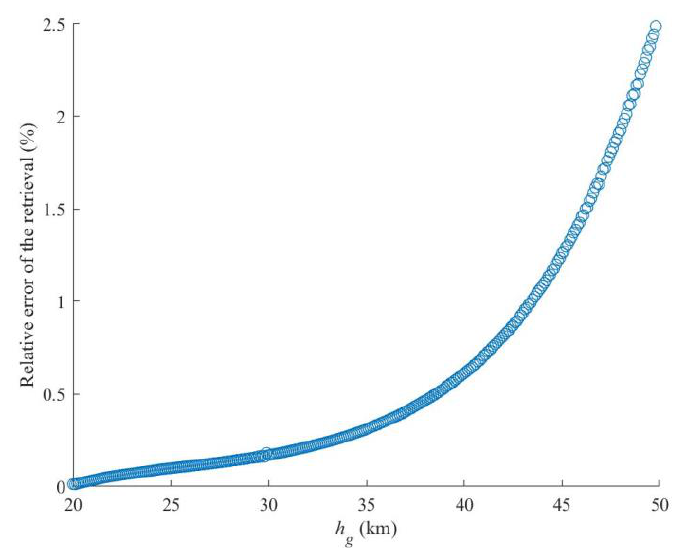
Figure 11. Relative error of the retrieval due to the assumptions with the tangent height.